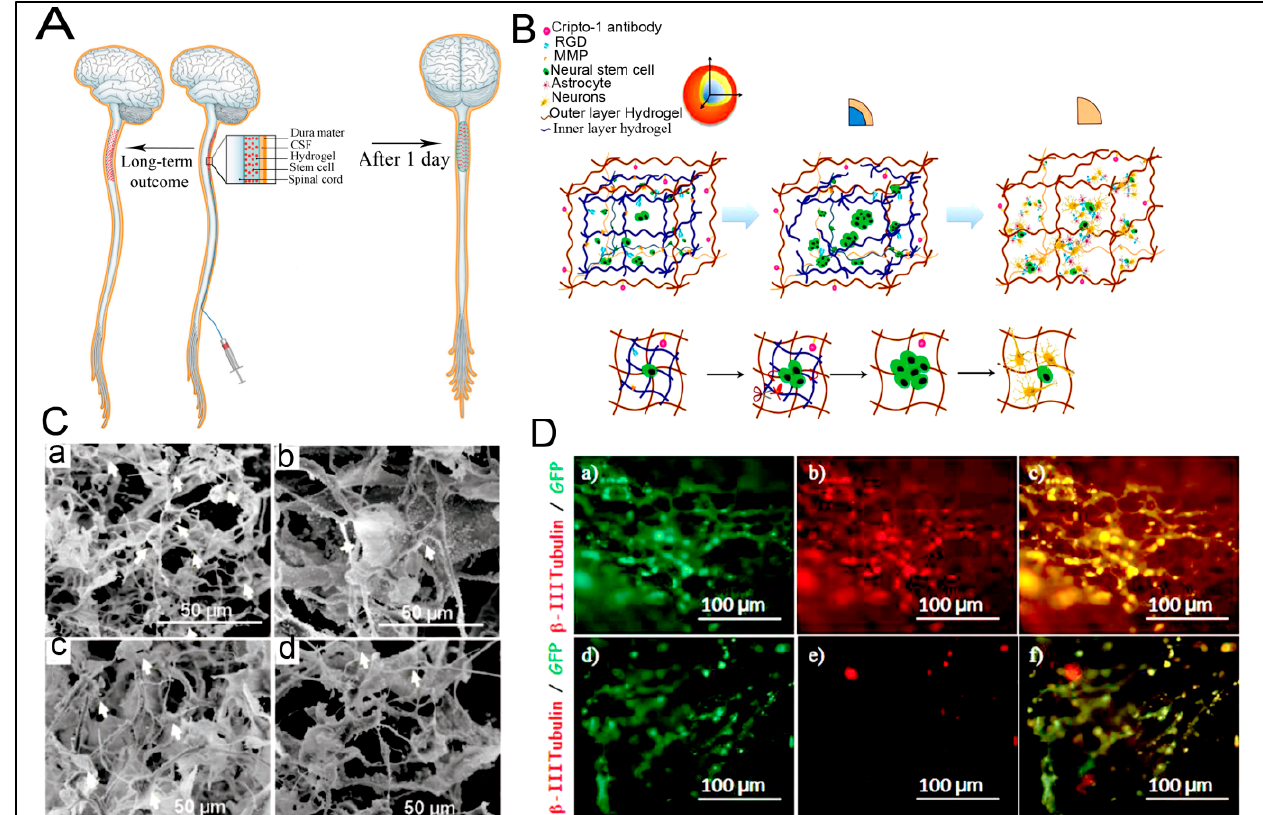
Figure 9. Hydrogel-based scaffolds to support and deliver neural stem cells (NSCs). ( A ) Schematic representation of hydrogel injection encapsulated NSCs into the spinal cord and short- and long-term outcomes. Reproduced with permission from Ref. [257], Copyright 2018, Springer Nature. ( B ) An illustration of intelligent double-layer hydrogel along with matrix metalloproteinases (MMP) and arginine-glycine-aspartate (RGD) peptides at the inner layer and Cripto-1 antibody at the outer layer for NSCs delivery and proliferation. ( C ): ( a – d ) Scanning electron microscopy (SEM) images of differentiated NSCs cultured with 50 μ g.mL − 1 of Cripto-1 antibody hydrogel. ( D ) Promoting the survival and differentiation of NSCs transplanted in vivo by the designed hydrogel. ( a , d ) are GFP staining, ( b , e ) represent β -III Tubulin, and ( c , f ) demonstrate the merged channels of GFP and β -III Tubulin. Reprinted with permission from Ref. [261], Copyright 2018, Wiley